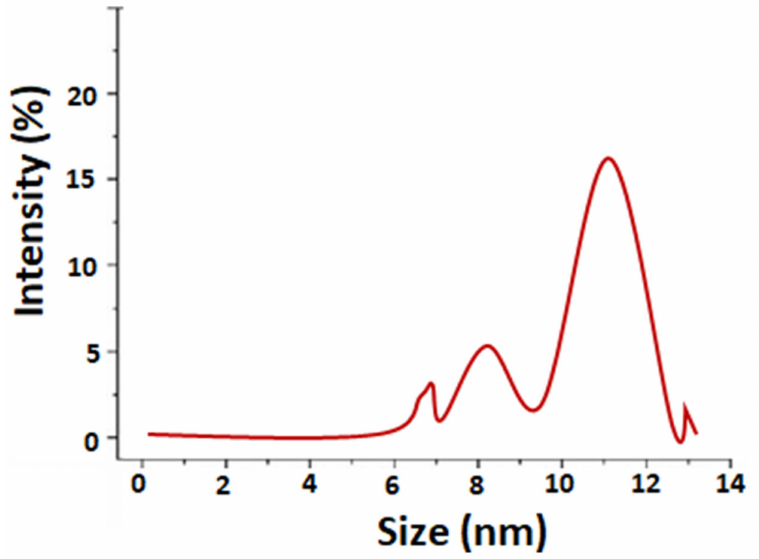
Figure 4. Size distribution analysis of Ag NPs-PTA measured by